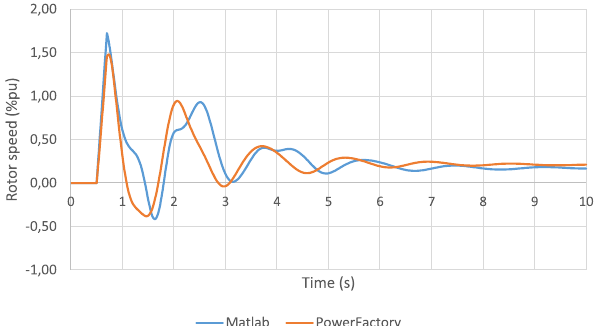
Fig. 2. Evolution of the rotor speed of generator 4 from Matlab IEEE-Benchmark and PowerFactory. Fig. 3. Illustration of the way to assess the three estimators considered in this paper.